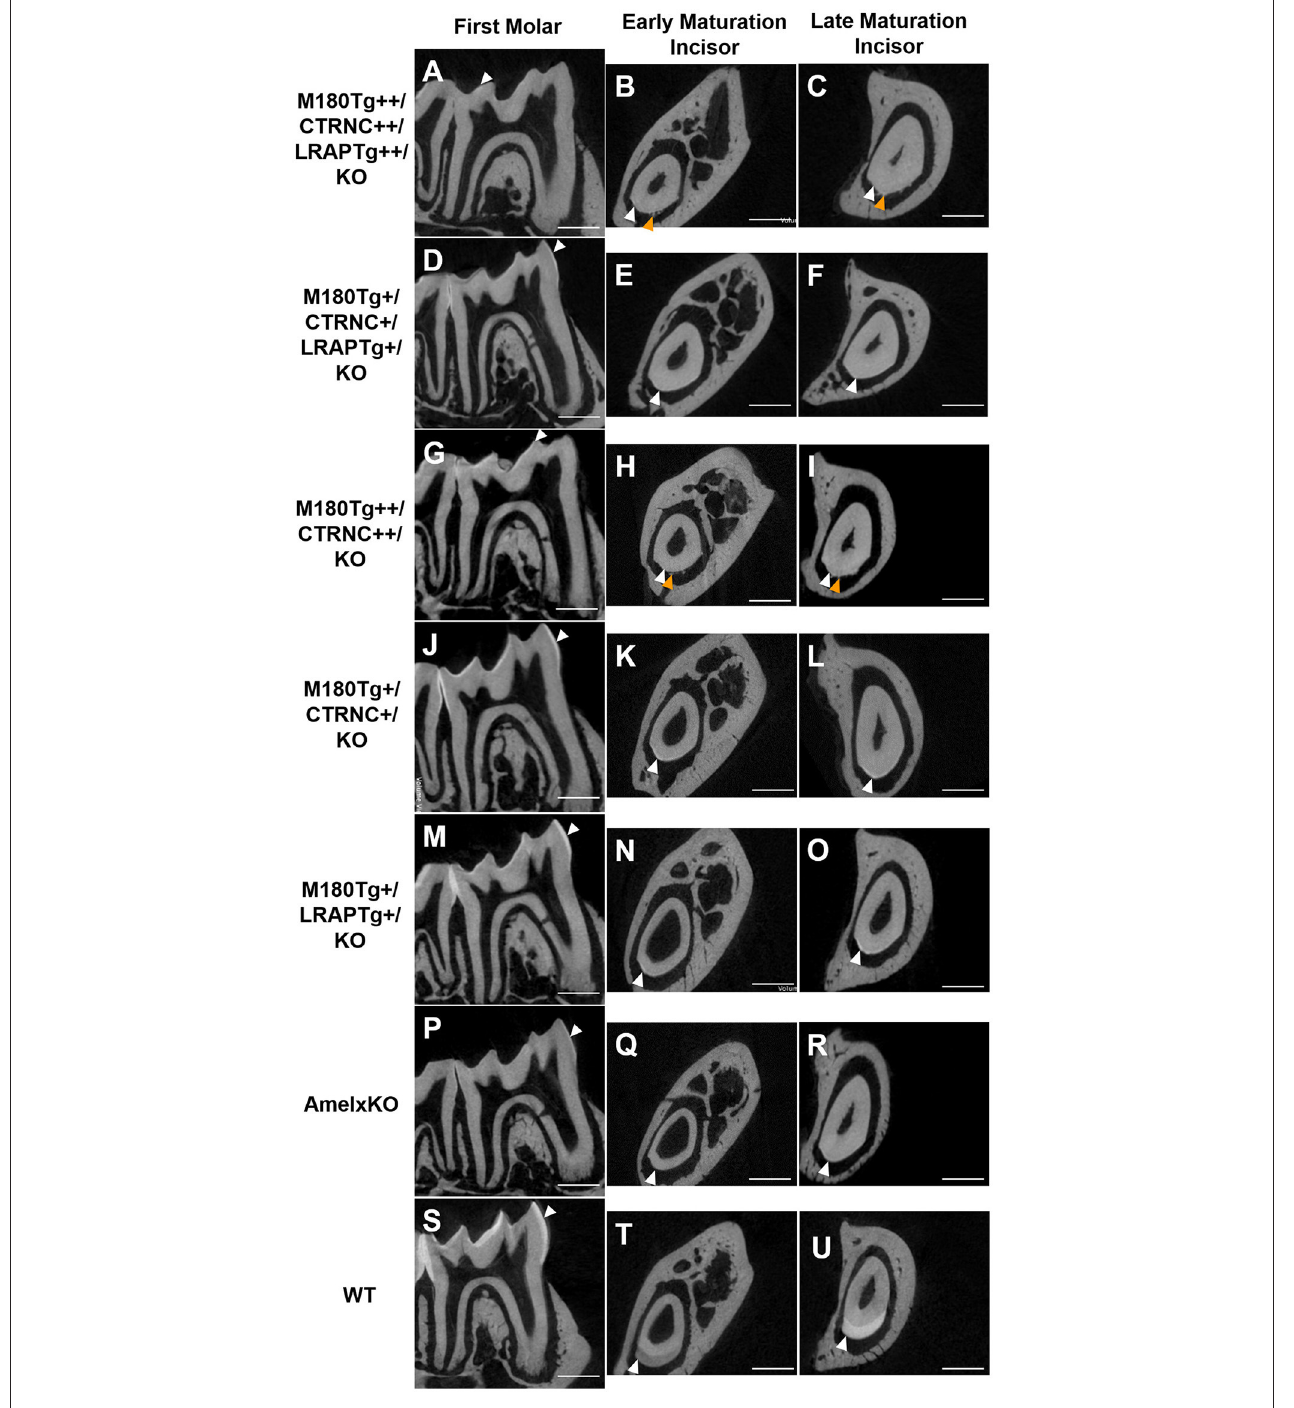
FIGURE 2 | MicroCT analyses of adult molar and incisor enamel. First column: first molars in mid sagittal plane. Middle column: Incisor enamel in coronal plane through the distal root of the first molar, representing early maturation stage. Last column: Incisor enamel in coronal plane adjacent and mesial to the first molar, representing maturation stage enamel. White arrowheads point to mineralized enamel layers visible in molars and incisors. WT seen in last row (S–U) ; (P–R) Amelx KO with little enamel on molars and no enamel in the incisor enamel. (A–C) homozygous triple transgene M180 Tg /CTRNC Tg /LRAP Tg /KO ++ , showing the thinnest enamel layer compared to all samples shown on both molars and incisors. (D–F) Hemizygous triple transgene M180 Tg /CTRNC Tg /LRAP Tg /KO + and (M–O) hemizygous double transgene M180 Tg /LRAP Tg /KO + with thicker enamel than all other transgene phenotypes shown, but thinner than WT. (G–I) double transgene M180 Tg /CTRNC Tg /KO ++ with a thin layer of enamel as is also seen in (J–L) M180 Tg /CTRNC Tg /KO + . Ectopic depositions (orange arrowheads) were visible in incisors of homozygous transgenes M180 Tg /CTRNC Tg /LRAP Tg /KO ++ and M180 Tg /CTRNC Tg /KO ++ (A–C, G–I) . Scale bars, 500 µ m.